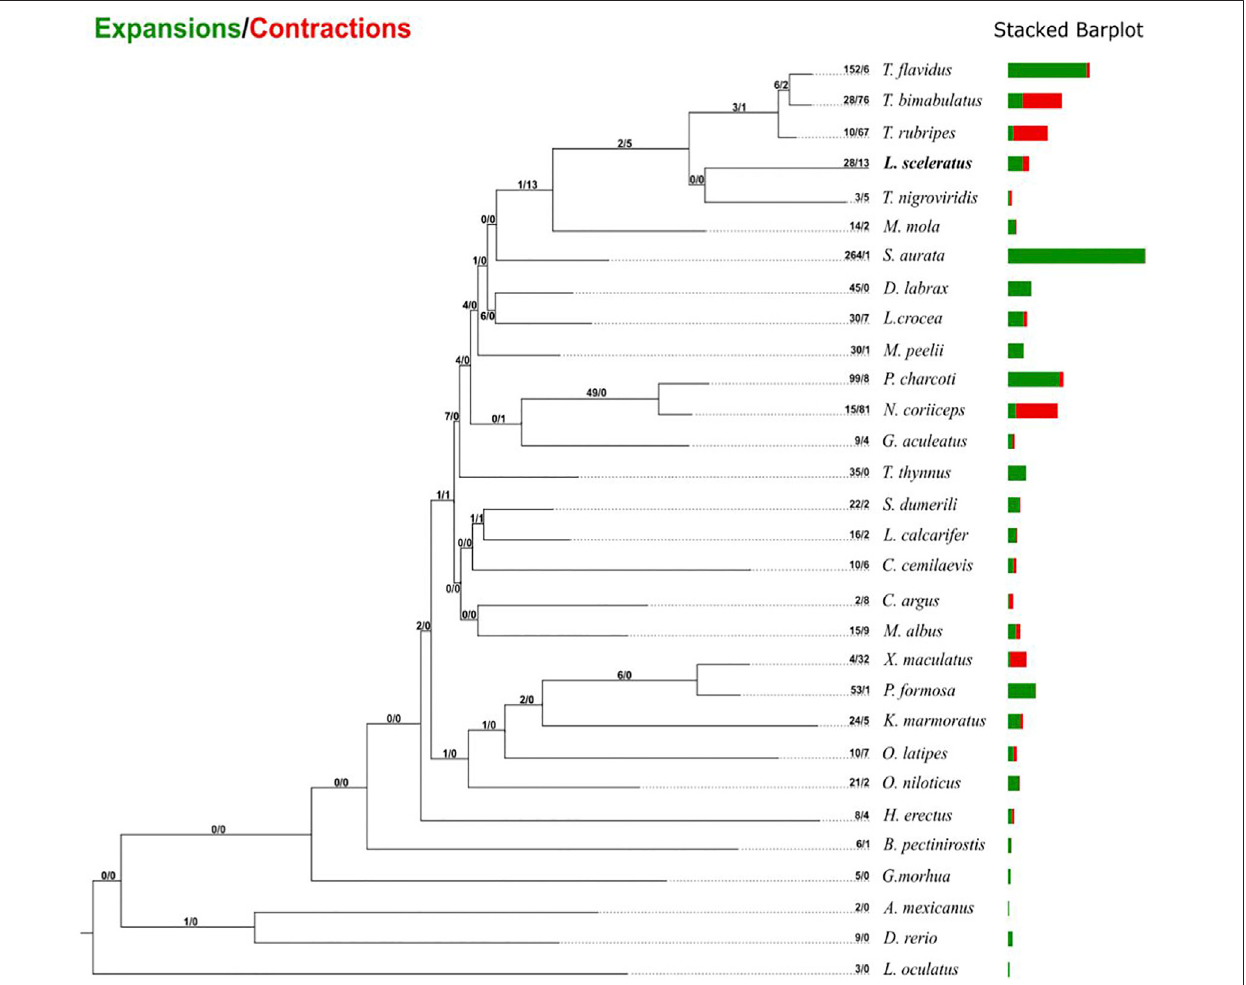
FIGURE 3 | Gene family gain-and-loss analysis, including the number of gained gene families (green) and lost gene families (red). The stacked barplot on the right indicates the gains and losses per species.